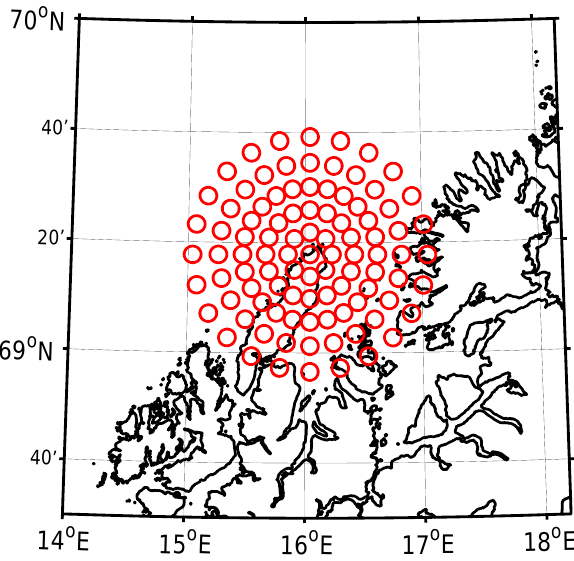
Fig. 1. Beam position of MAARSY scanning experiment during summer 2011. The black contour lines indicate the Northern Norwegian coast line. The red circles represent the beam positions assuming a 3.6 ◦ beam width at 84 km.